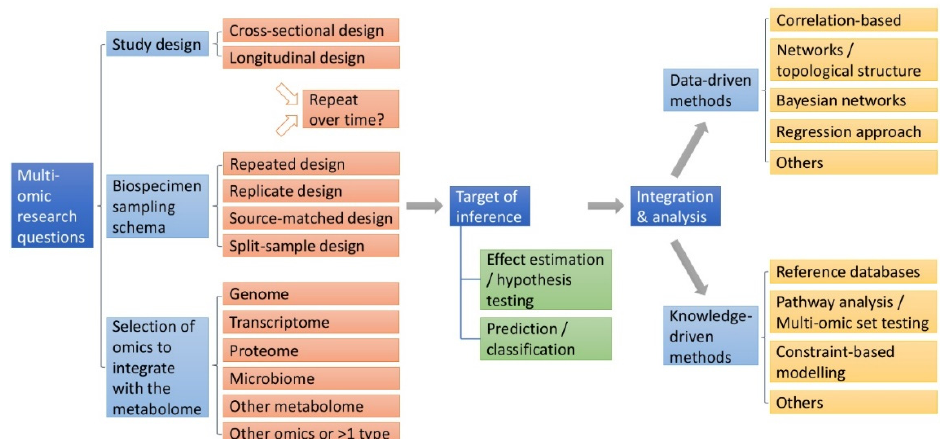
Figure 2. Framework for multi-omic study design and analysis. Explicitly defined research questions in a multi-omic investigation should inform three aspects of the study: study design, biospecimen sampling schema, and selection of additional omic type(s) to be integrated with the metabolome. Given the target of inference, be it e ff ect estimation / hypothesis testing, prediction / classification, or both, we may choose appropriate methods for integration and